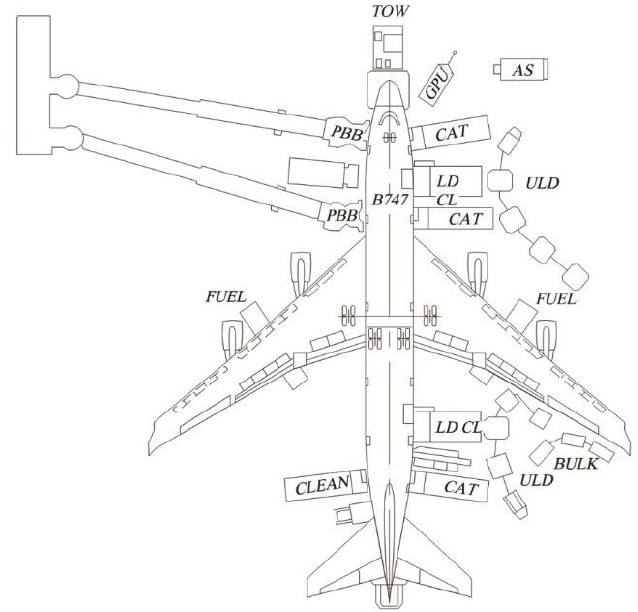
Figure 1. Typical FGHP space layout. TOW: tow tractor; GPU: ground power unit; AS: air start unit; PBB: passenger boarding bridge; CAT: catering; LDCL: cargo loading; ULD: unit load devices; FUEL: